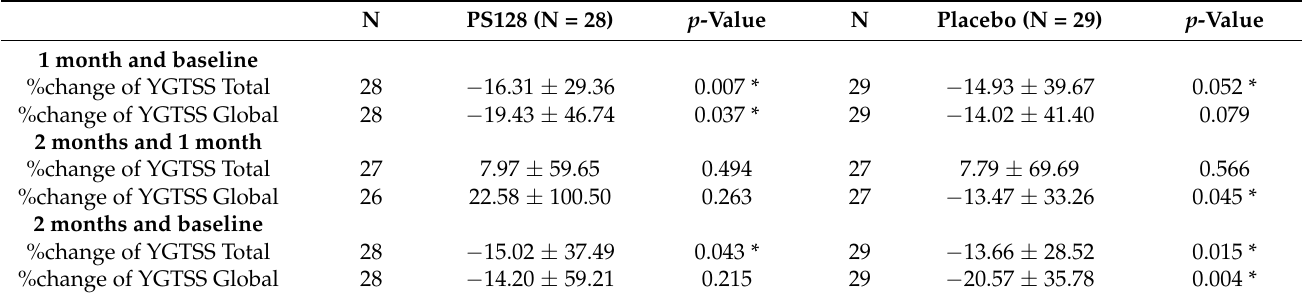
Table 3. Paired t analysis of % of change in YGTSS total and global scores between 2 months, 1 month, and baseline.